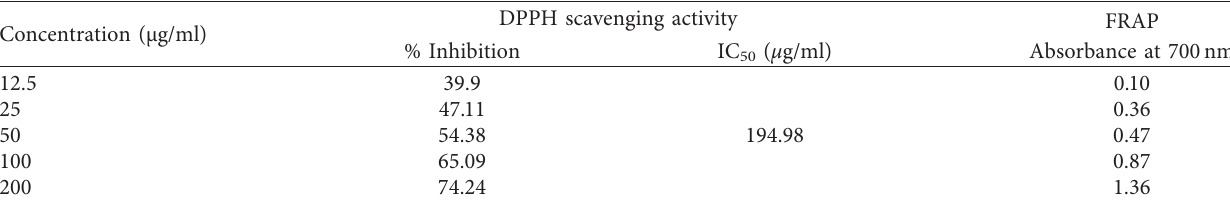
Table 9: Percentage of DPPH inhibition and FRAP test